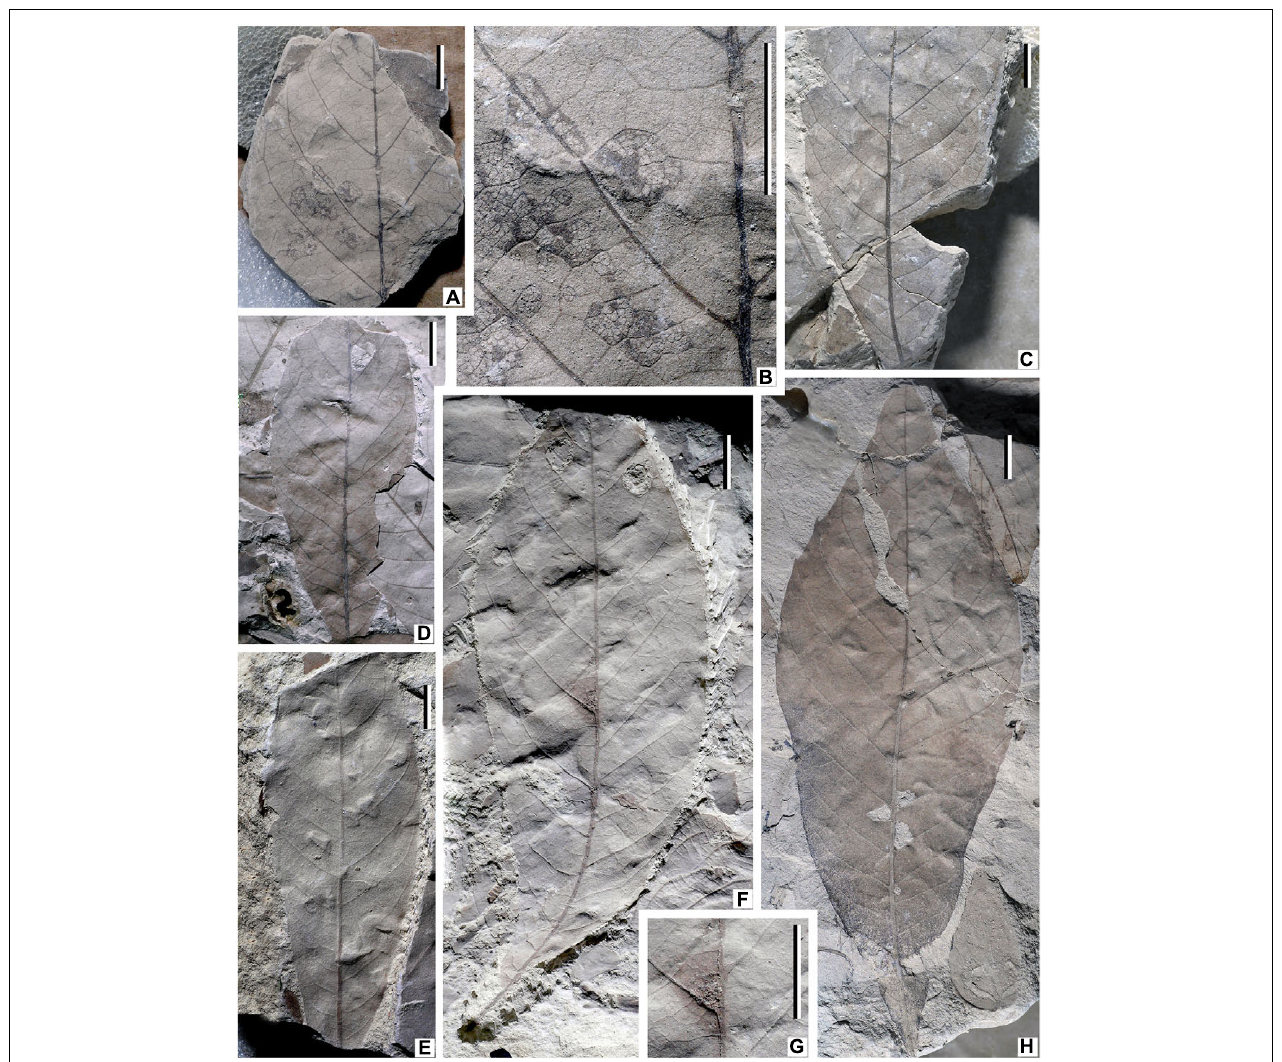
FIGURE 5 | Fossil leaves of M. eosinica sp. nov. from the Eocene Huangniuling Formation of the Maoming Basin, South China. (A) Incomplete leaf showing skeletonization insect damage (DT17), MMJ3-321. (B) Enlargement of leaf in (A) , polygonal skeletonized patches with reaction tissue bounded by tertiary veins. (C) Lower part of the leaf, MMJ3-549-1. (D) Untoothed leaf with large polylobate perforation (DT5) caused by an insect, MMJ3-2207-2. (E) Untoothed leaf, MMJ3-2205-1. (F) Leaf with small teeth in the upper third of lamina, MMJ3-2206-2. Note circular holes (DT2, DT4) caused by insects and probable fungal damage in the domatium zone. (G) Enlargement of domatium zone in (F) . (H) Holotype (counterpart), MMJ3-008-1b. Scale bars = 1